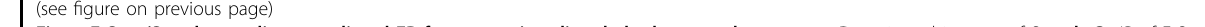
Fig. 5 E-Syt1/Syt7 heterodimer mediated ER fragmentation directly by lysosomal enzyme. a Domain architecture of Syt7. b Co-IP of E-Syt1 and Syt7. 293 T cells transfected with HA-Esyt1 and indicated plasmids of Syt7 mutants. Syt7 mutant proteins were immunoprecipitated using anti- mCherry antibody and the precipitates were analyzed using anti-HA antibody. c 786 O/OE-SR cells stably expressing GFP-Esyt1 were infected with mCherry or mCherry-tagged mutants with Syt7 by lentivirus, and nucleus stained with Hoechst 33342. Representative confocal images were shown. Scale bar 50 µm. Enlargement images, scale bar 10 µm. d Indicated plasmids of Syt7 mutants were transfected in 786 O/OE-SR cells with or without knockdown of E-Syt1. Lysates of cells were tested by WB. e 786 O/OE-SR cells transfected with Syt7 or empty vector. Representative TEM images showed that in some ER-Lysosome contact sites, ER was fragmented and engulfed by autophagosomes. Red area depicted the lysosome, yellow area indicated autophagosome, blue area indicated ER, light blue area indicated ER fragment. Scale bar 20 µm. Enlargement images, scale bar 4 µm. f 786 O/OE-SR cells transfected with Syt7 or mutated vector were treated with ER Tracker (yellow) and nuclear dye Hoechst 33342 (blue). ER morphology was assessed by confocal microscopy. Scale bar 20 µm. g Co-localization of Esyt1 and CTSB in 786 O/OE-SR cells after siRNA mediated knockdown of Syt7. Scale bar 10 µm. Thirty cells were randomly selected for each treatment. The number of binding sites between E-Syt1 and CTSB in each cell was counted and the experiment was repeated 3 times ( h ) 786 O/OE-SR cells transfected with Syt7 or empty vector were treated with CA-074Me (10 μ M) or DMSO for 24 h and then cells were incubated with ER Tracker (yellow) and nuclear dye Hoechst 33342 (blue). ER morphology was assessed by confocal microscopy. Scale bar 20